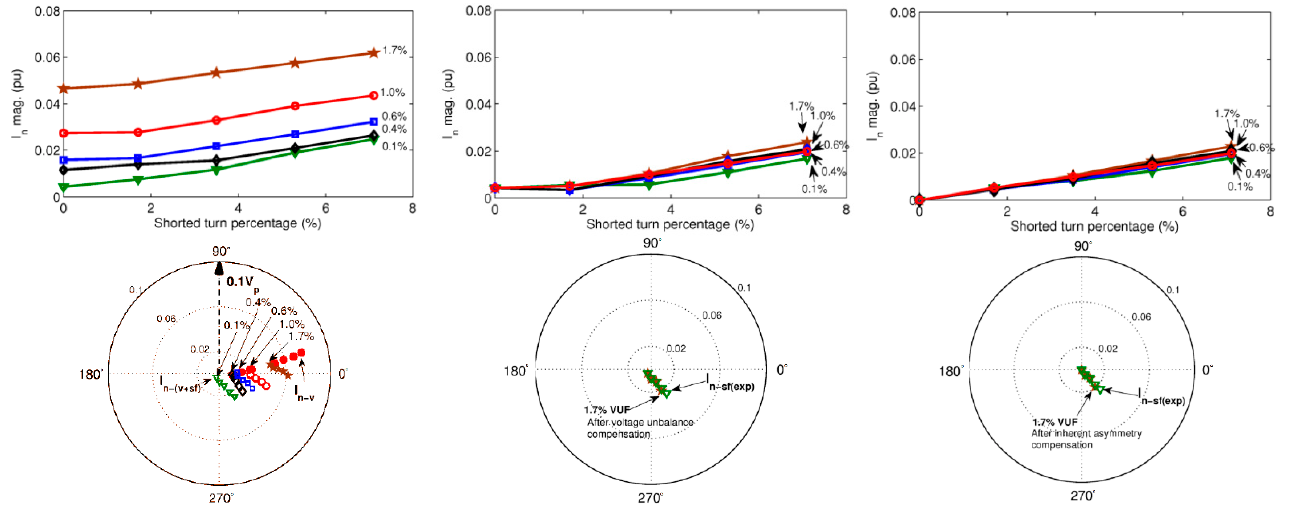
Figure 16. The test results (magnitude and phasor plots) of the negative sequence current magnitude as a function of shorted turn fault severity (up to 7.1%) with voltage unbalance factors between 0.1% to 1.7%: measured results ( left column ) after voltage unbalance compensation ( middle column ) and after both voltage unbalance and inherent asymmetry compensation ( right column ).